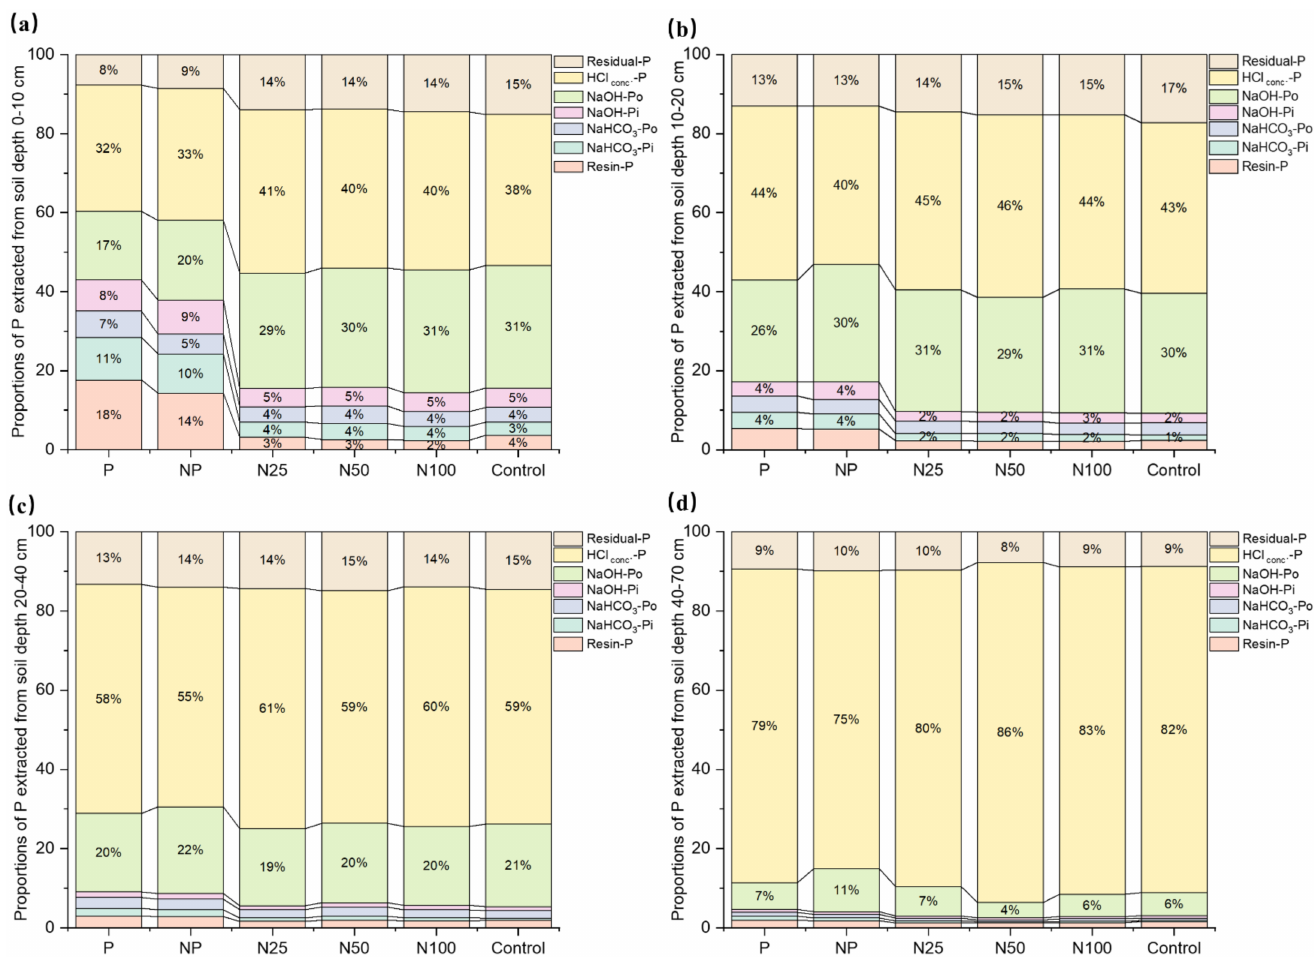
Figure 1. Proportions of P-extracted Hedley fractions from soil depth increments: ( a ) 0–10 cm; ( b ) 10–20 cm; ( c ) 20–40 cm; and ( d ) 40–70 cm. Table 3. Soil P contents ( µ g g − 1 ) from each soil depth for seven Hedley fractionations in